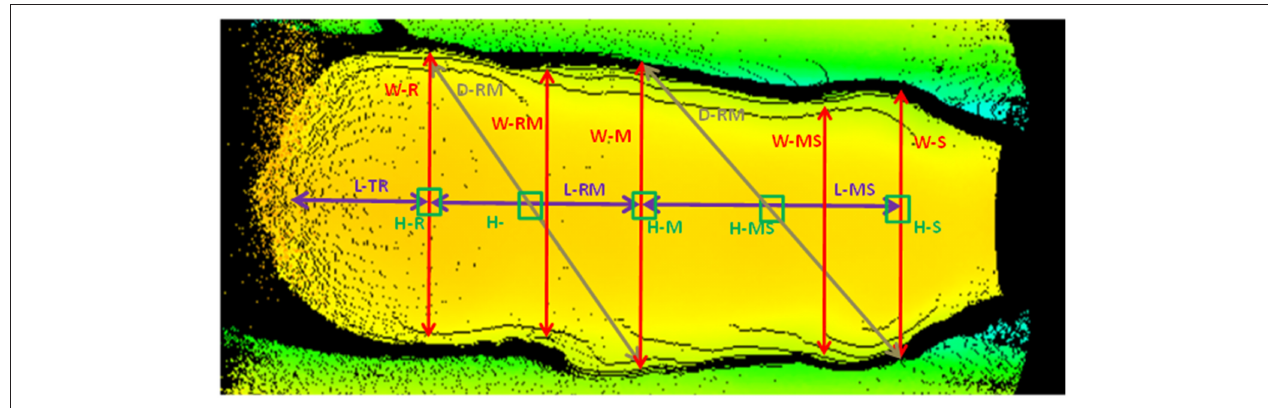
FIGURE 1 | Measurements acquired from 3D images. W, width; L, length; D, diagonal; H, height; S, shoulder; M, middle; R, rump, T, tail.